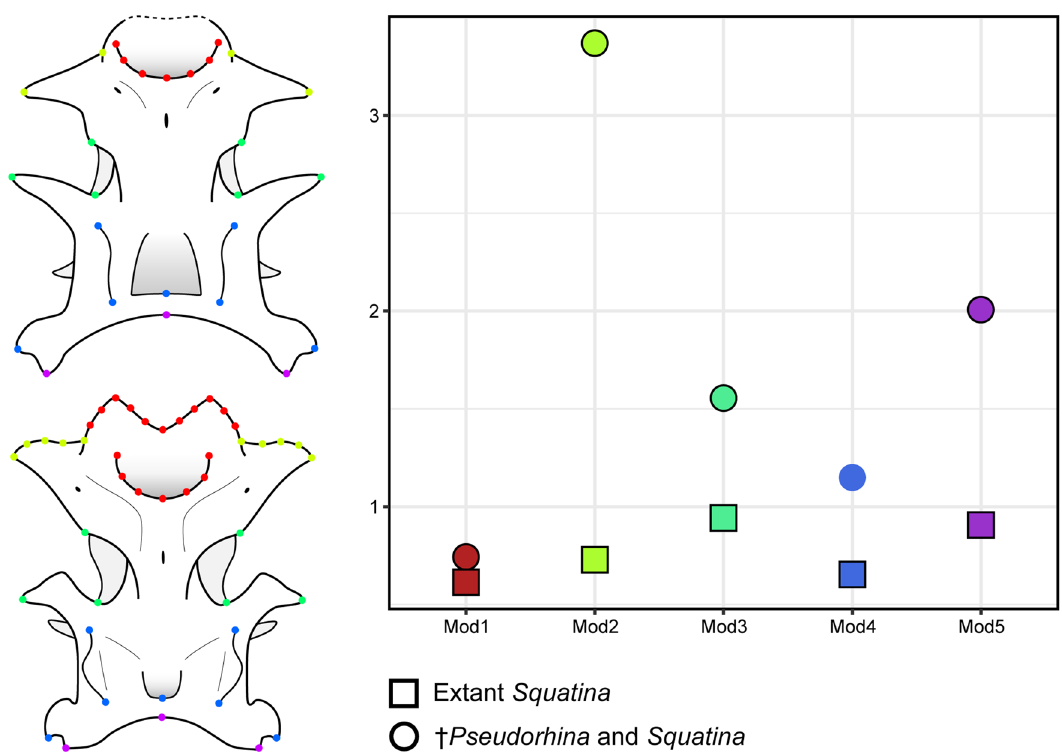
Figure 6. Rate of morphological evolution for selected modules on the neurocranium of the angel sharks, circles indicate the analysis on the complete data set and squares the dataset with only living angel sharks. Modules defined after de Carvalho et al. 27 Mod1: Rostrum; Mod2: Nasal capsules; Mod3: Orbit; Mod4: Otic capsules; Mod5: